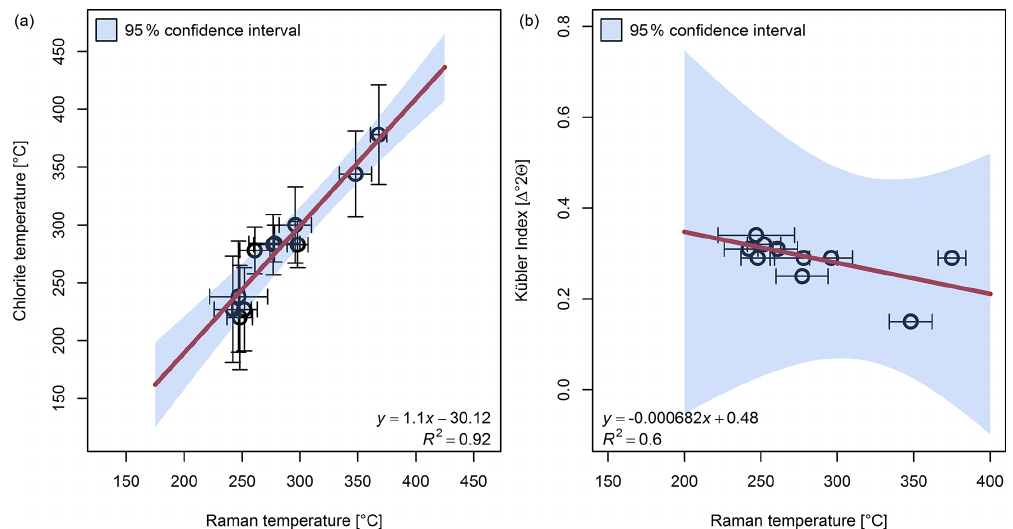
Figure 8. Comparison between T max obtained from Raman spectroscopy on carbonaceous matter and (a) chlorite T max and (b) KI values. Note that Raman- and chlorite temperatures have a strong correlation with a small confidence interval and regression slope of approximately 1. In contrast, the uncertainty in the KI is too large for any reliable temperature